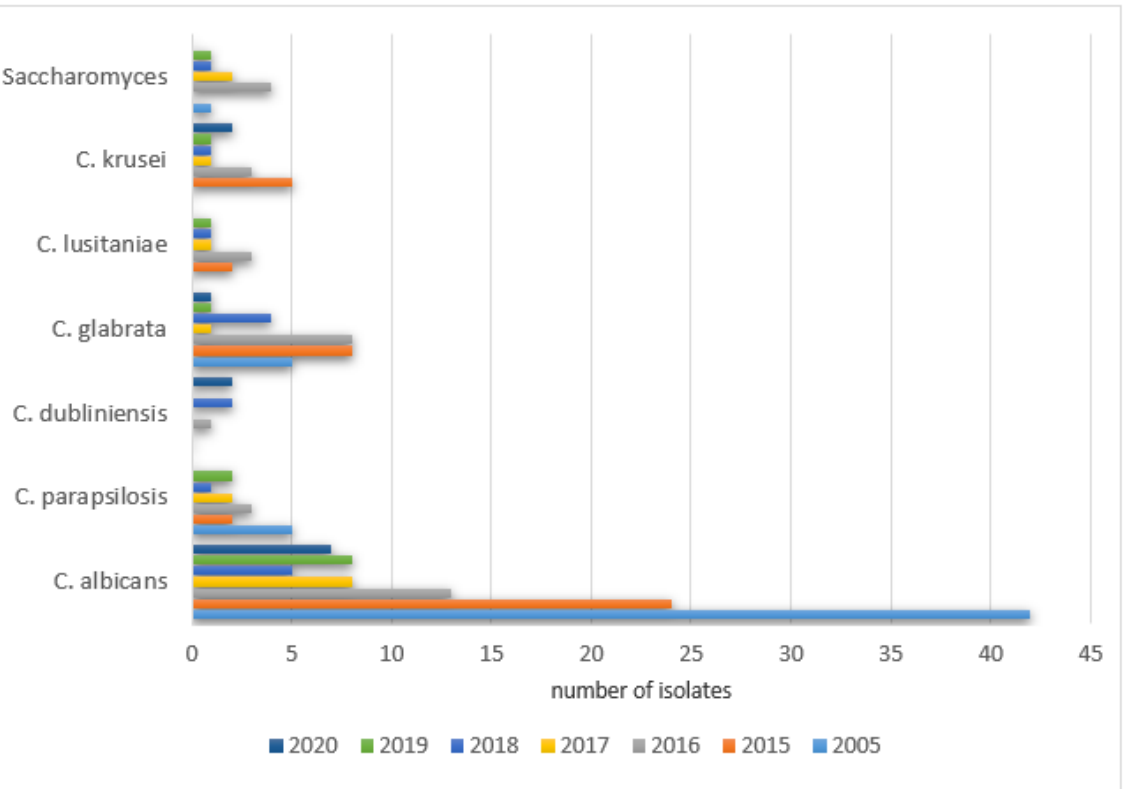
Figure 8. Most frequently isolated yeast species from samples collected in the NICU each year.